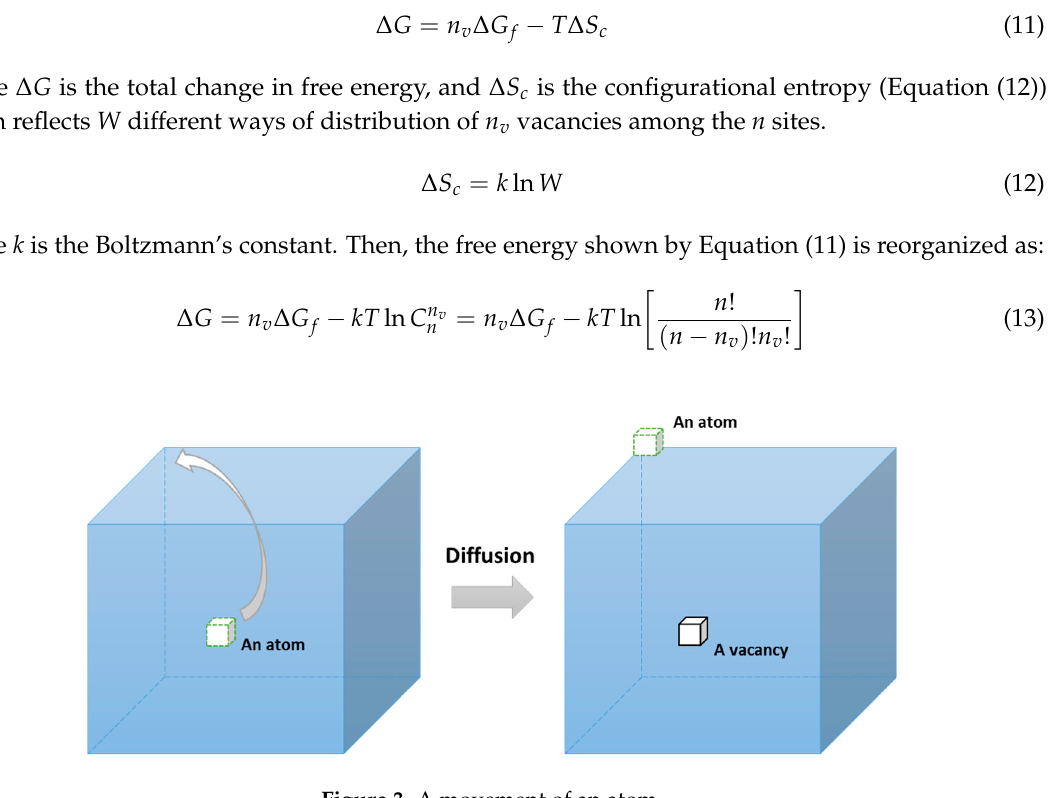
Figure 3. A movement of an atom.